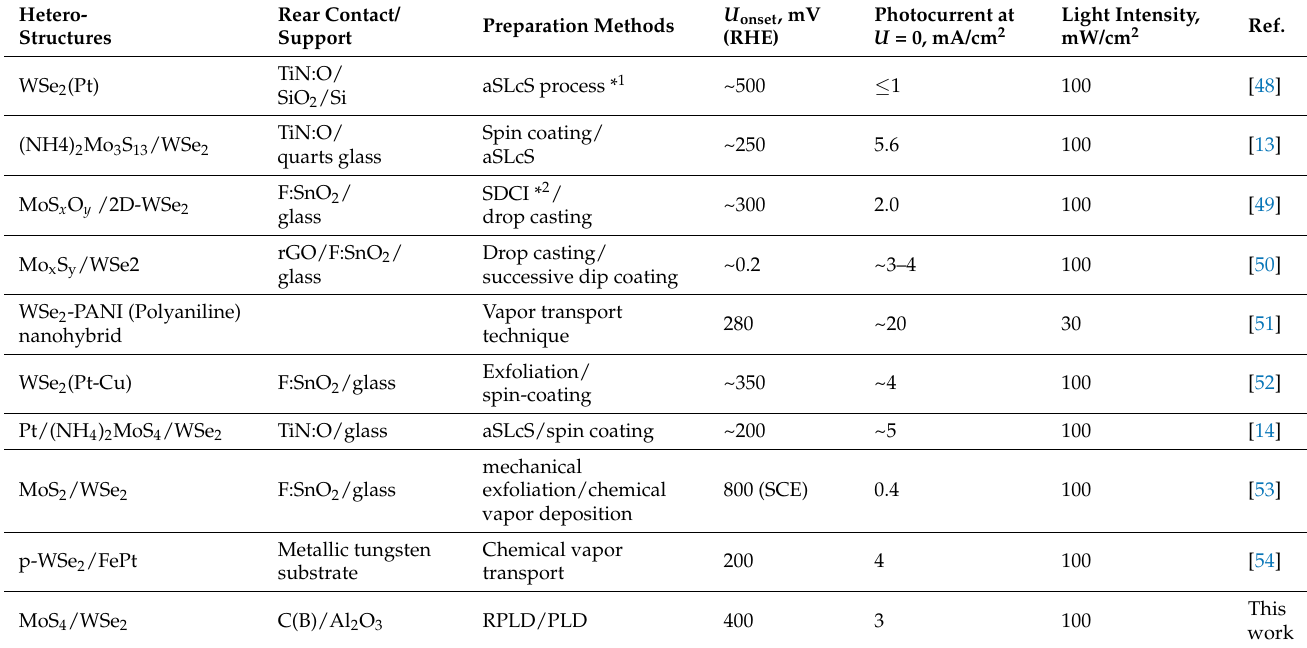
Figure 13. ( a ) Chopped LSV curve for the MoS x ~4 /WSe 2 /C(B)/Al 2 O 3 photocathode in 0.5 M H 2 SO 4 upon illumination; ( b ) Chopped photocurrent density versus time for MoS x ~4 /WSe 2 /C(B)/Al 2 O 3 (curve 1 ), MoS x~4 /C(B)/Al 2 O 3 (curve 2 ) and WSe 2 /C(B)/Al 2 O 3 (curve 3 ) photocathodes at 0 V (RHE) in 0.5 M H 2 SO 4 upon illumination. Comparison of photo-assisted HER performances for metal chalcogenide-based photocathodes with heterojunction